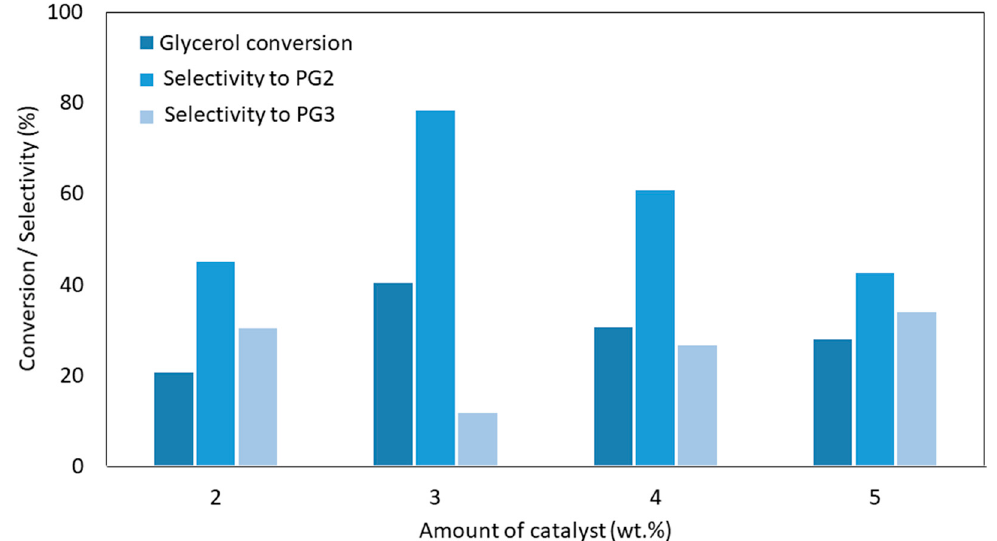
Figure 10. Catalytic conversion of glycerol over 7.5% Ca-MgAl mixed metal oxide at 220 °C for 24 h (reproduced from [60]).